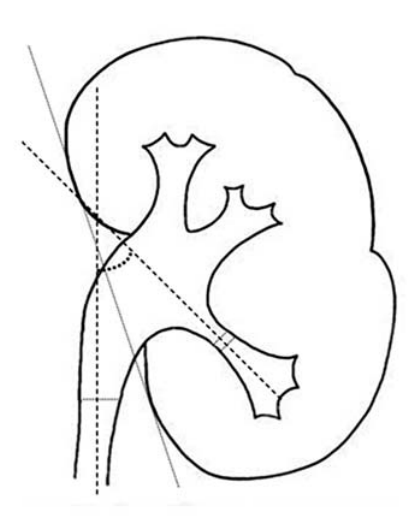
Figure 4 – Infundibulopelvic angle (º), described as the angle between the line drawn through the central axis of the lower infundibulum and the ureteropelvic